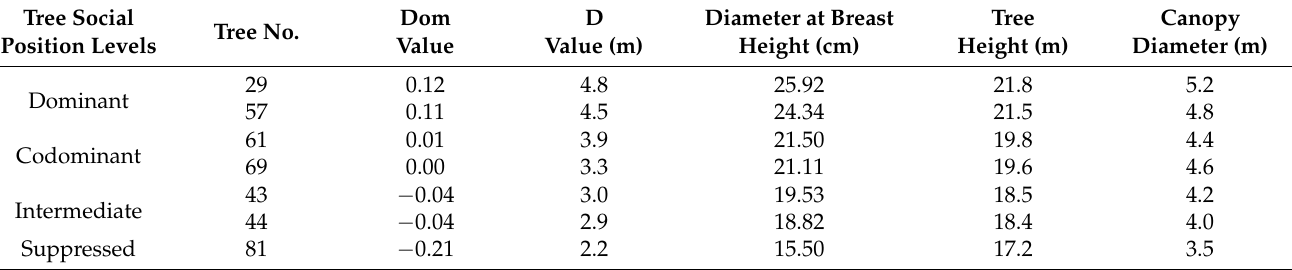
Table 4. The characteristics of seven sample trees in the down slope plot ( DS